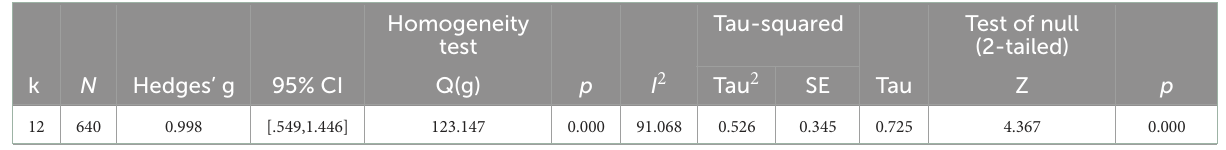
TABLE 2 Overall mean ES summary and test for heterogeneity.